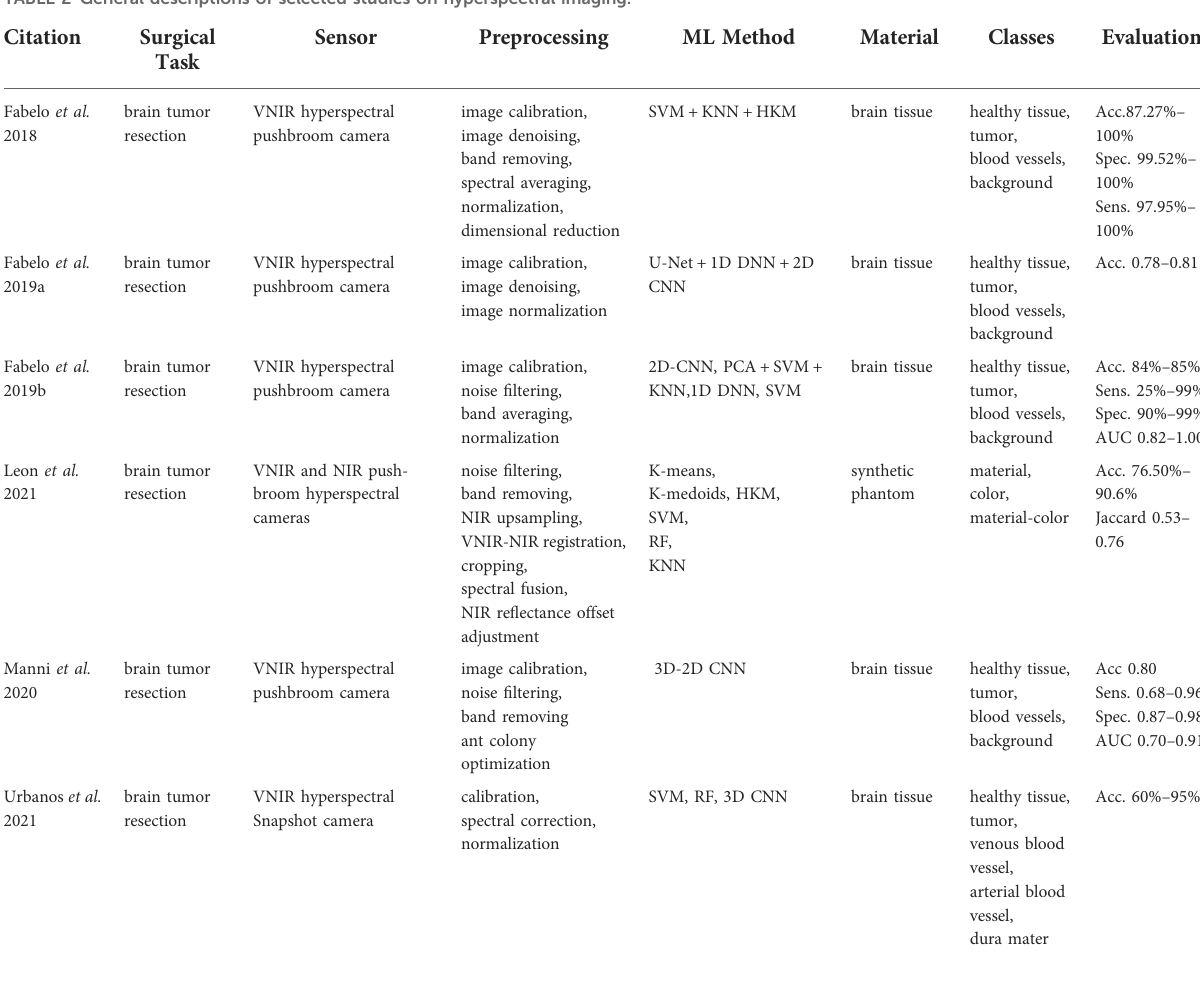
TABLE 2 General descriptions of selected studies on hyperspectral